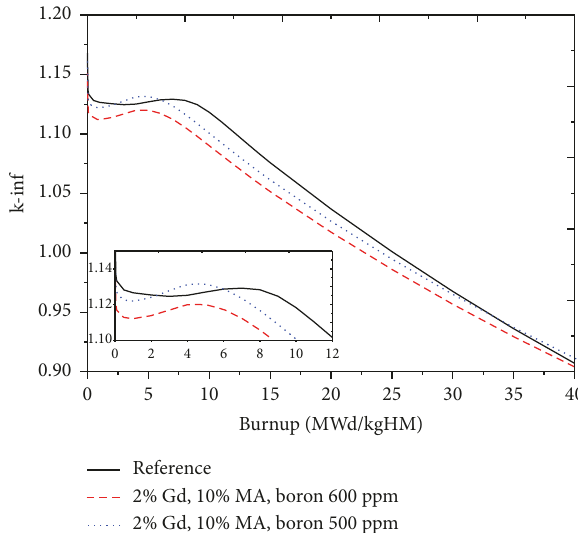
Figure 4: The k-inf versus burnup when loading 6wt.% of MAs and reducing GD to 2 wt.%.